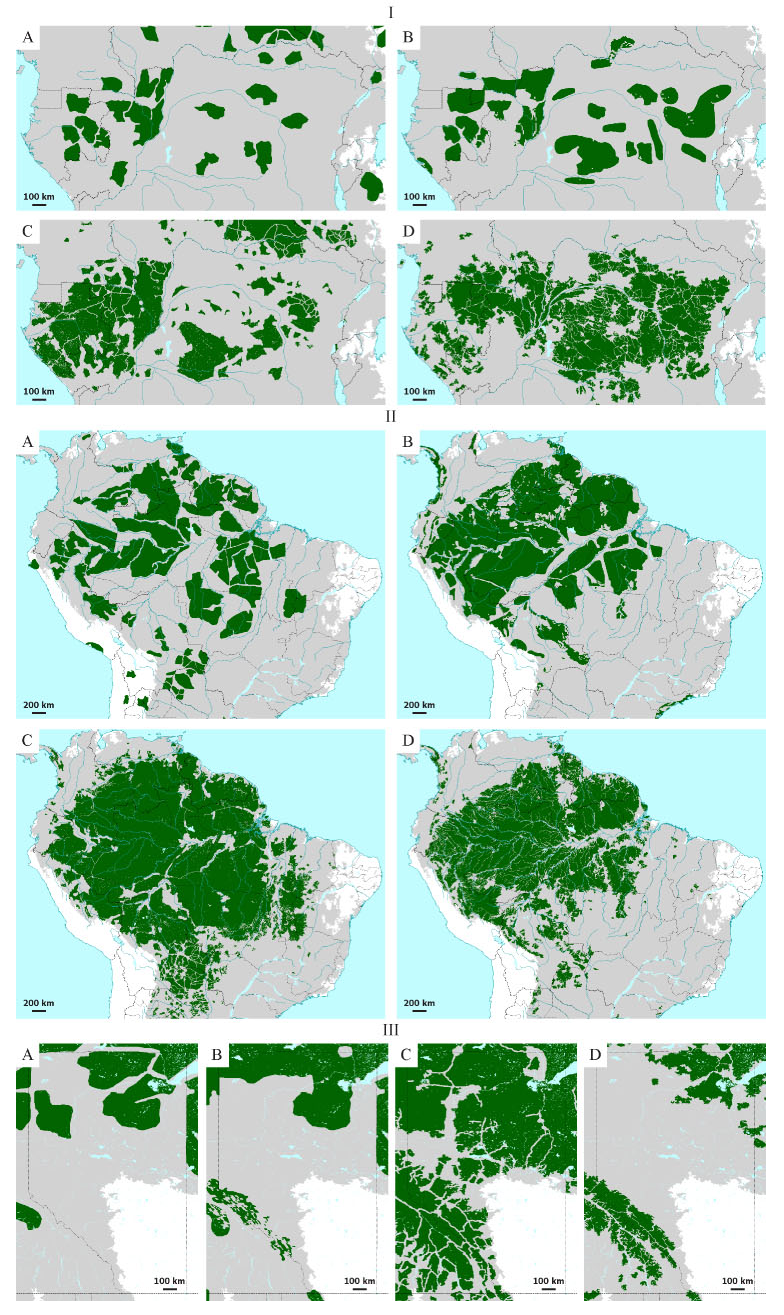
Fig. 4. Comparison of (A) the Wilderness Areas map by McCloskey and Spalding (1989); (B) Frontier Forests map by Bryant et al. (1997); (C) Intact areas map produced on the base of the Human Footprint data set by Sanderson et al. (2002), and (D) IFL mapping results for different regions: I – Tropical Africa; II – Amazon basin; III – Canadian province Alberta.; Intact areas (green); the rest of forest zone